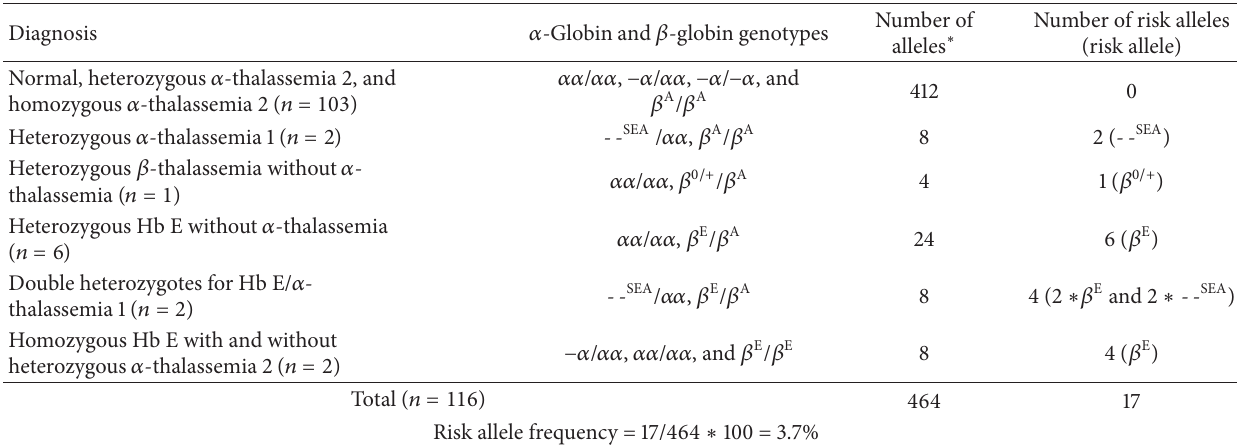
Table 4: Number of risk alleles and risk allele frequency in Southern Thai blood